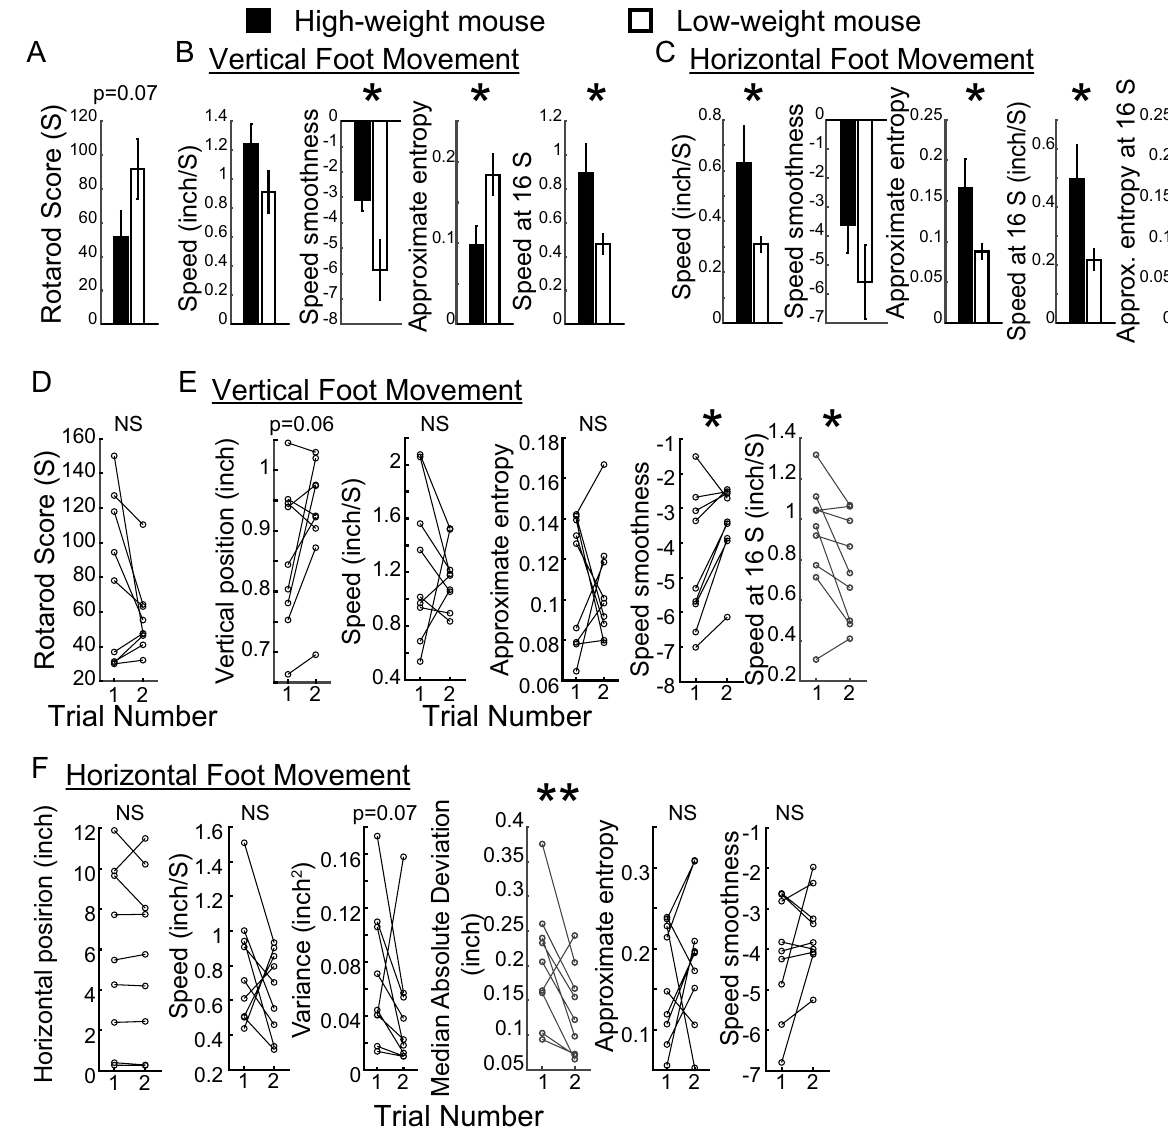
Figure 5. Comparison of first trial features between mice groups and with second trial. ( A – C ) Rotarod score ( A ) and vertical height and horizontal ( B , C ) intra-session features in smaller-weight (n = 6) and greater-weight (n = 6) mice. Bar charts illustrate means and error bars represent standard error of mean for rotarod score and intra-session features for vertical paw position. * = p < 0.05, ** = p < 0.01, (unpaired Student’s t -test). ( D , E ) Change between the first and second trial in rotarod scores ( D ) and vertical ( E ) and horizontal ( F ) intra-session features in all mice tested (n = 9). * = p < 0.05, ** = p < 0.01 (paired Student’s t